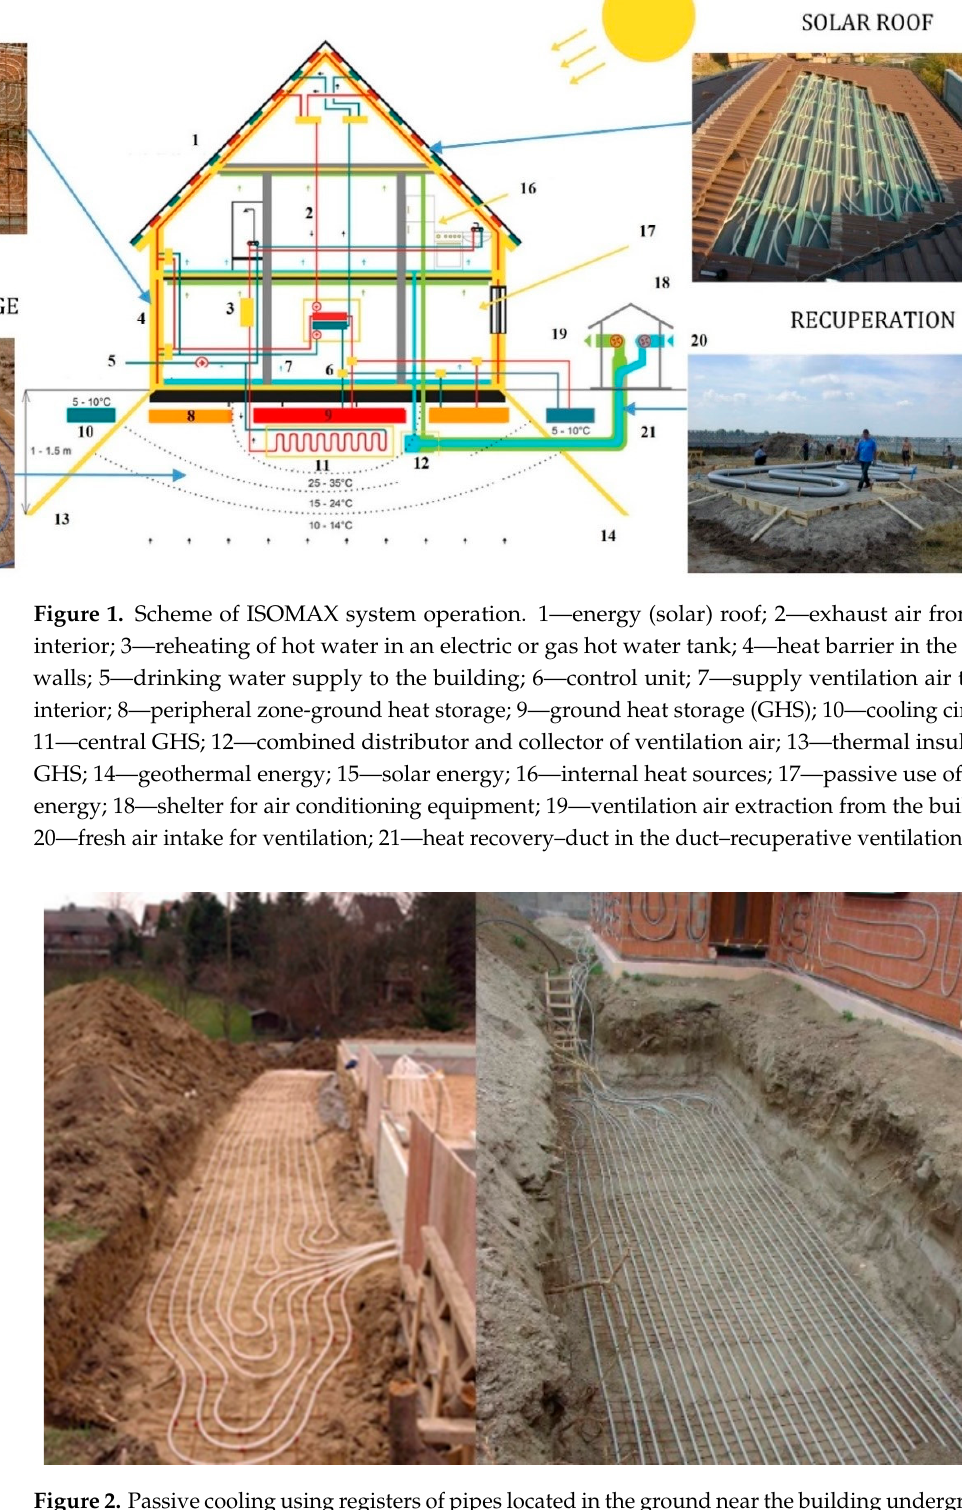
Figure 2. Passive cooling using registers of pipes located in the ground near the building underground at a depth of 1 to 2 m [1,2].